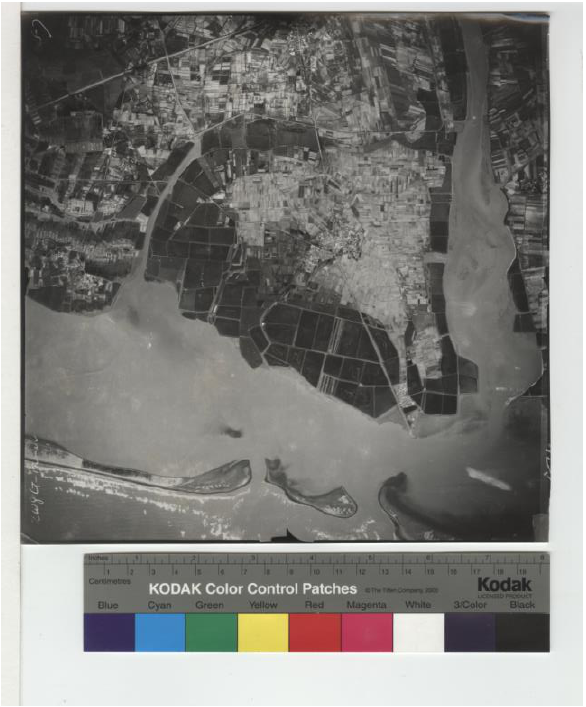
Figure 1. Example of scanned photograph.